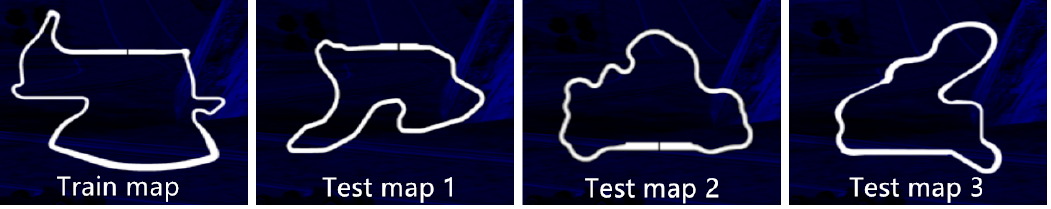
Figure 4. Training and testing map.